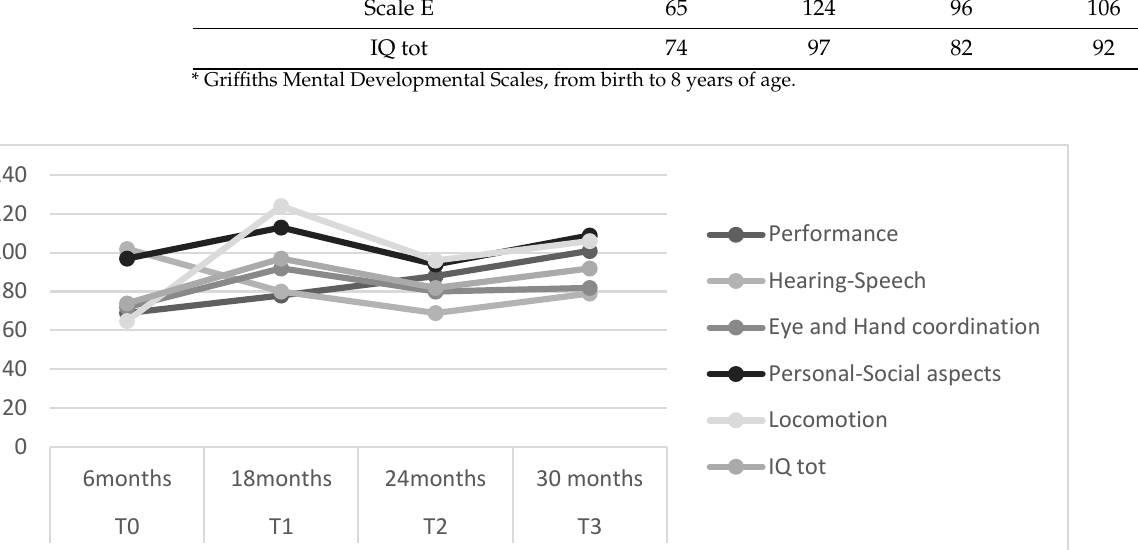
Figure 1. Line Plot. Representation of distribution of clinical assessment in each time.